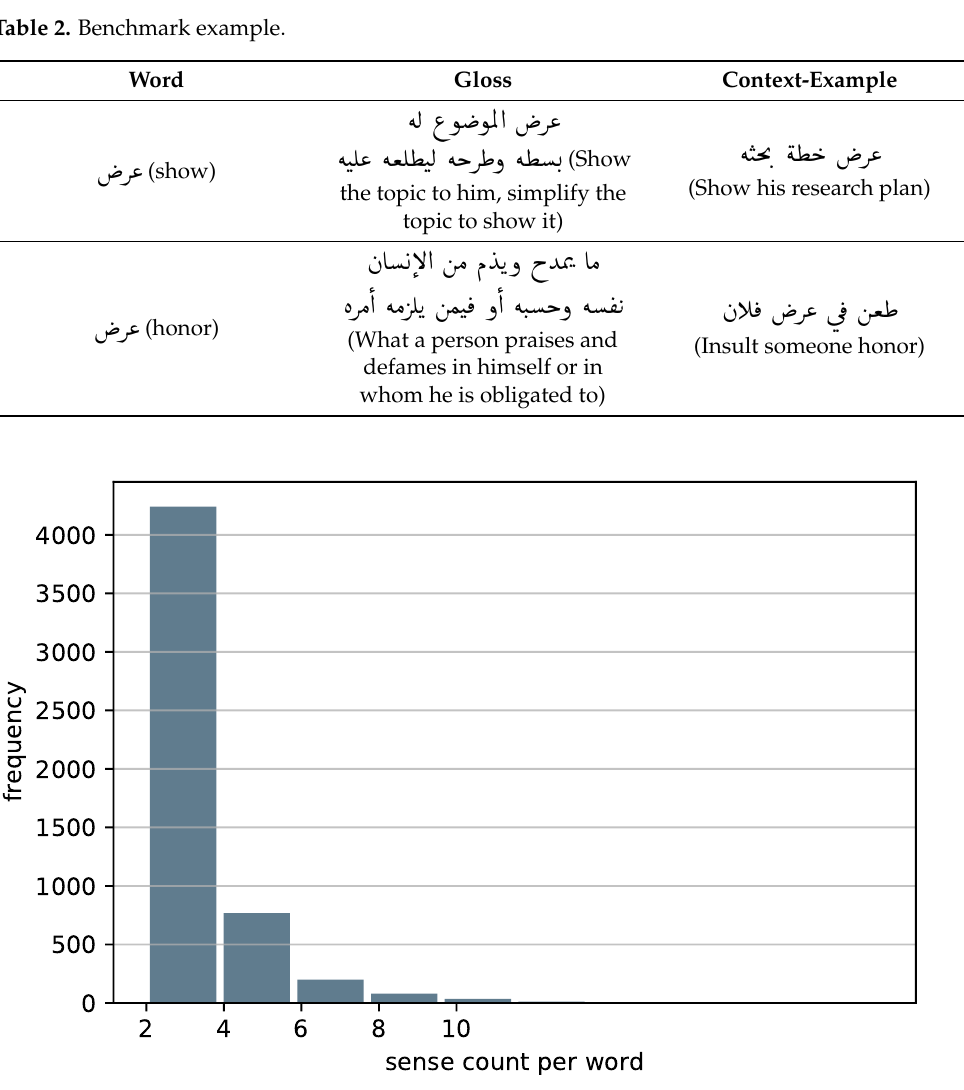
Figure 1. Histogram of benchmark senses per